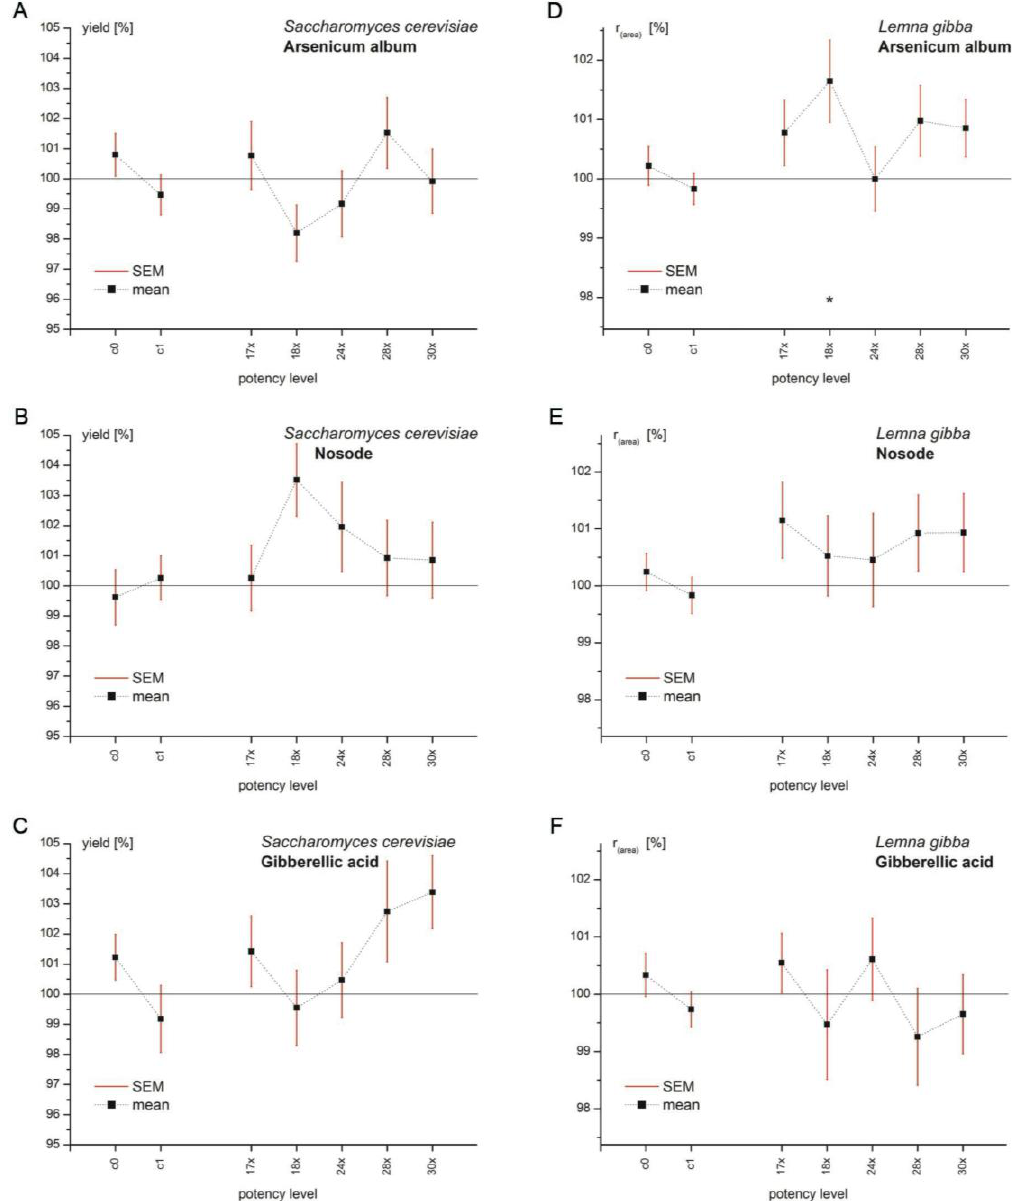
FIGURE 5. Growth kinetics of Saccharomyces cerevisiae (yield) (%) and area-related specific growth rates (r days 2–6) (%) of L. gibba growing in different potency levels of selected test (area) substances (A–C, D–F) in comparison to the corresponding water controls (c0 + c1). Mean values (dots) ± standard error for five independent experiments, respectively. Every data point for a single potency level is a mean from five independent experiments, with either eight replicates (wells) each for yeast (n = 40 per data point) or five replicates (beakers) each for duckweed (n = 25 per data point plotted). For yeast, the two data points for controls are an average from five independent experiments with 24 wells (succussed controls) or 16 wells (unsuccussed controls) (n = 120 and n = 80 per data point plotted). For duckweed, the two data points for the controls are an average from five independent experiments with 25 beakers (succussed controls) or 20 beakers (unsuccussed controls) (n = 125 and n = 100 per data point plotted). Data were normalized to the experimental mean of succussed and unsuccussed water controls (c0 + c1) for every individual experiment. Lines connecting data points are not